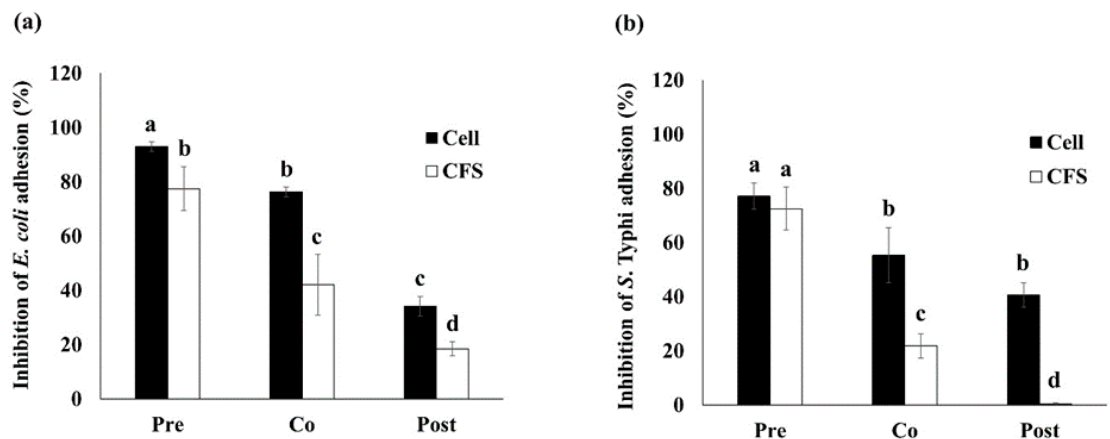
Figure 2. The inhibition of E. coli ( a ) and S. Typhi ( b ) adhesion to Caco-2 cell by bacteria cell and CFS of E. faecium OV3-6. Three conditions: E. faecium OV3-6 was treated on Caco-2 cell at 1 h before pathogenic bacteria was added as pre-incubation (Pre); E. faecium OV3-6 and pathogenic bacteria were added at the same time as co-incubation (Co); E. faecium OV3-6 was treated on Caco-2 cell at 1 h after pathogenic bacteria was added as post-incubation (Post). Data are shown as means ± SD of triplicate experiments. The different letters above columns indicate that the values are significantly different ( p <